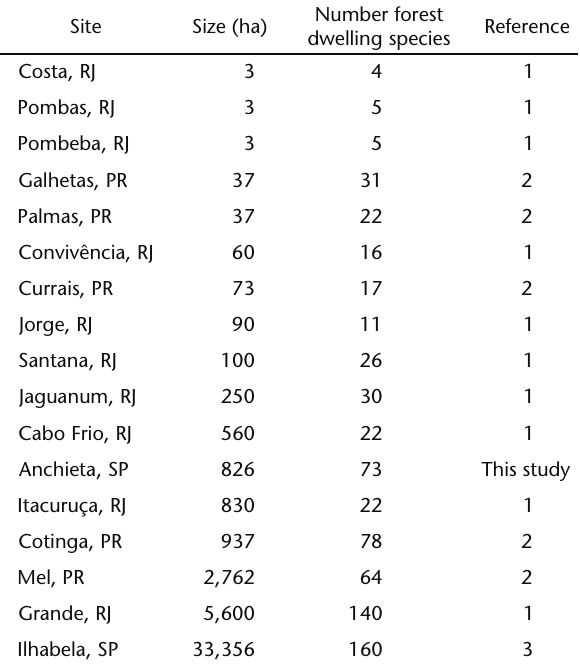
Table I. Bird species richness and island size on the inshore islands in the Atlantic rain forest,